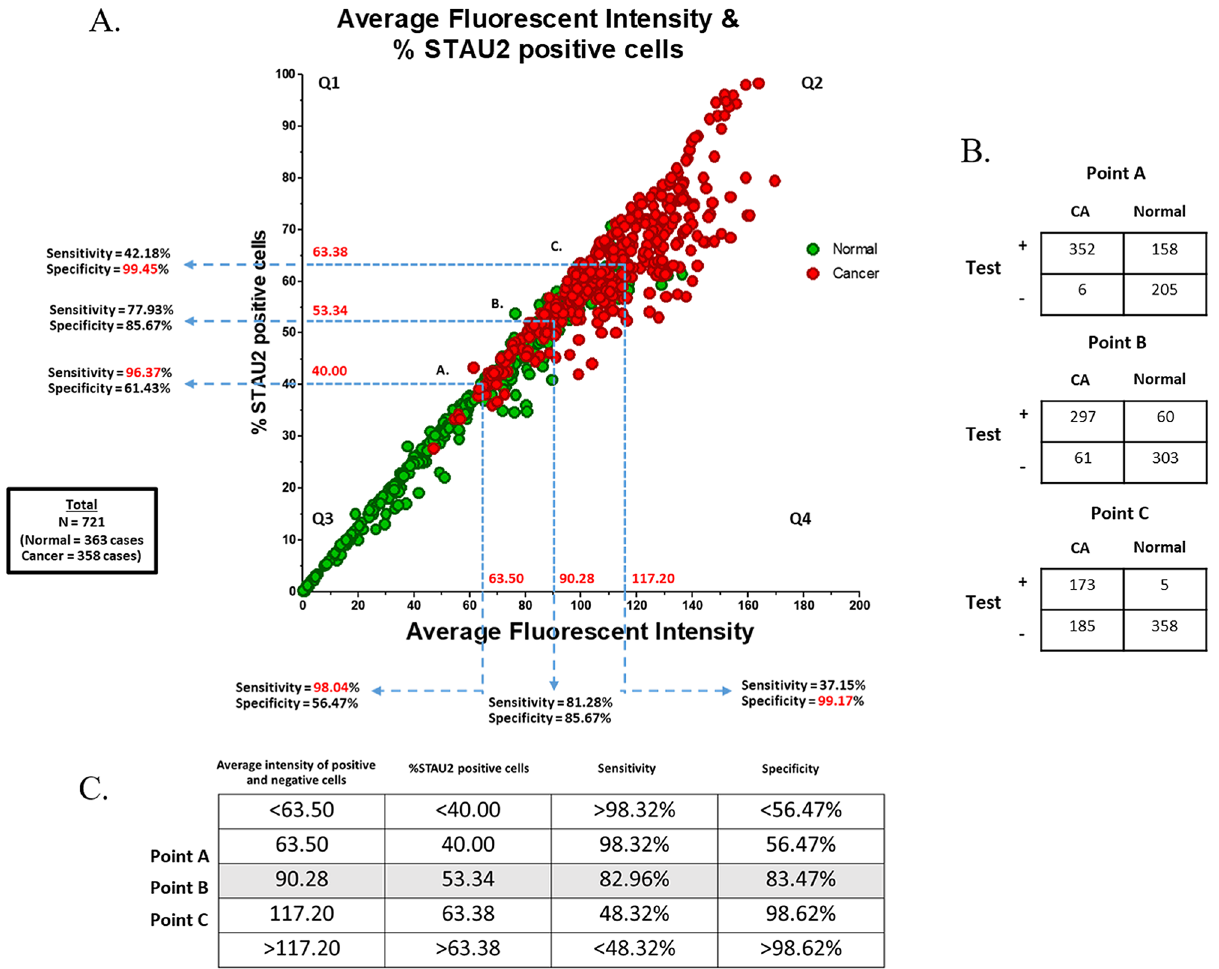
Figure 5. The fluorescent signal of STAU2 in all samples (N = 721) for cut-off point evaluation. ( A ) Three cut-off points (A, B, C) were evaluated. High sensitivity (82.96%) and high specificity (83.47%) were noted at cut-off point B. The intensity detection and the percentage of STAU2-positive cells were operated by CellSens imaging software (Olympus Co., Ltd., USA). ( B ) The 2 × 2 table of positive and negative cases based on cut-off points A, B and C for sensitivity and specificity calculation. ( C ) The sensitivity and specificity details for cut-off points A, B and C showed that cut-off point B was the balanced cut-off point ( p = 3.56 × 10 –71 , odds ratio = 24.59, 95% CI = 16.64–36.34) with low false positive and negative rates (high accuracy = 83.22%, NPV = 0.8324, PPV =